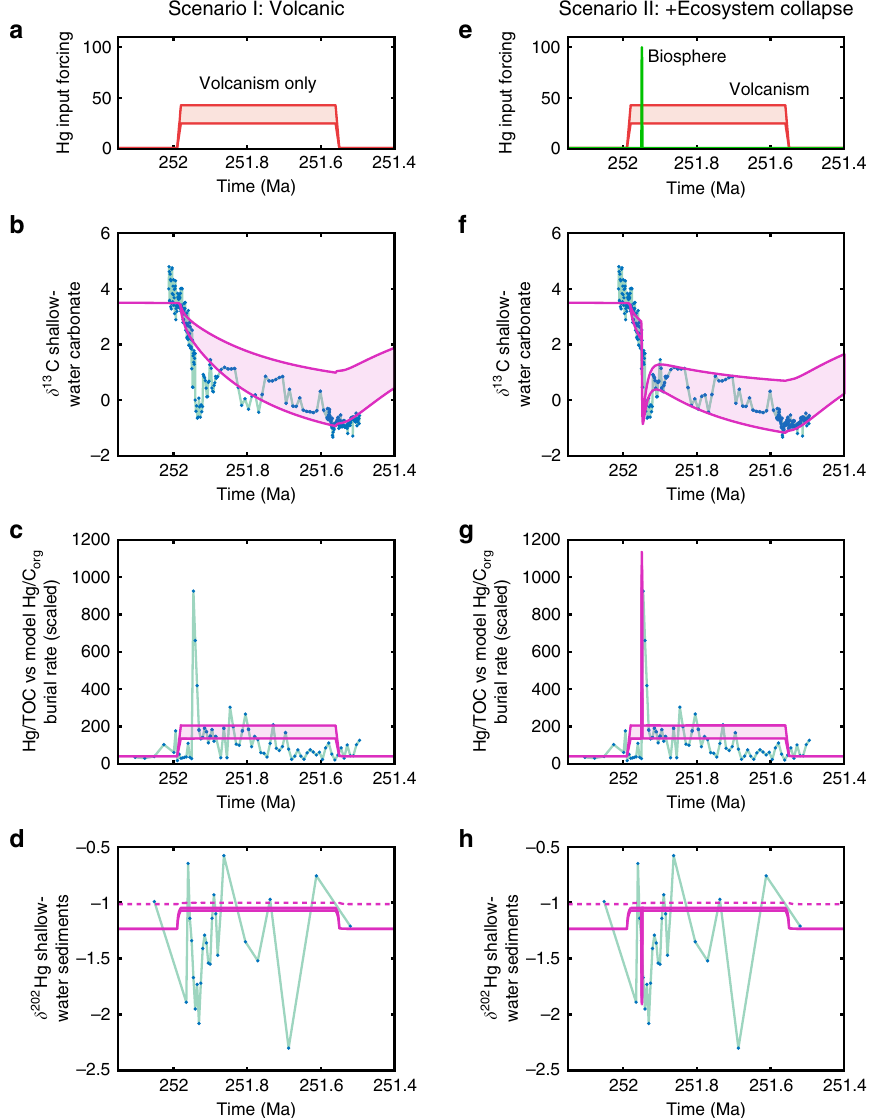
Fig. 3 Model results. a – d Volcanic C and Hg source only (thermogenic plus magmatic). e – h With addition of ‘ vegetation loss ′ Hg source and corresponding increase in organic carbon oxidation. C-isotope, Hg/TOC and δ 202 Hg data from ‘ Meishan GSSP' section 20,23 . In both columns, top panel ( a , e ) shows input forcing in terms of relative rate of Hg input, next panel ( b , f ) shows δ 13 C of new shallow ocean carbonate, third panel ( c , g ) shows Hg/TOC data versus the model molar Hg/C org burial rate, which has been scaled to match the background as the model does not calculate weights. Final panel ( d , h ) shows model δ 202 Hg against data, where solid line is shallow water (box s) and dashed line is deep water (box d) Blue dots = published data; Red and green lines = model Hg fl uxes; Pink lines = model